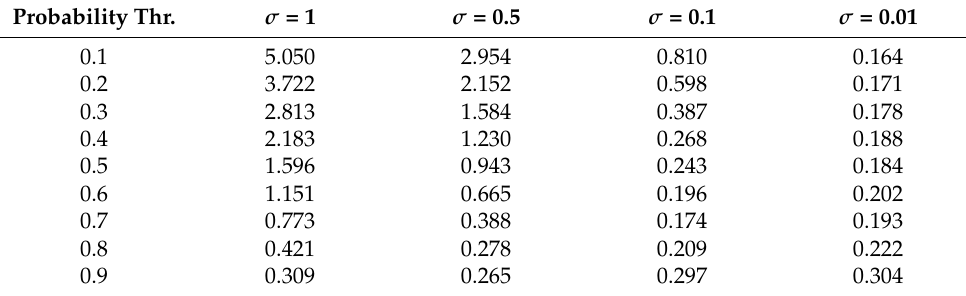
Table 2. Loss values of our insect-counting algorithm with Soft-NMS. Probability Thr.